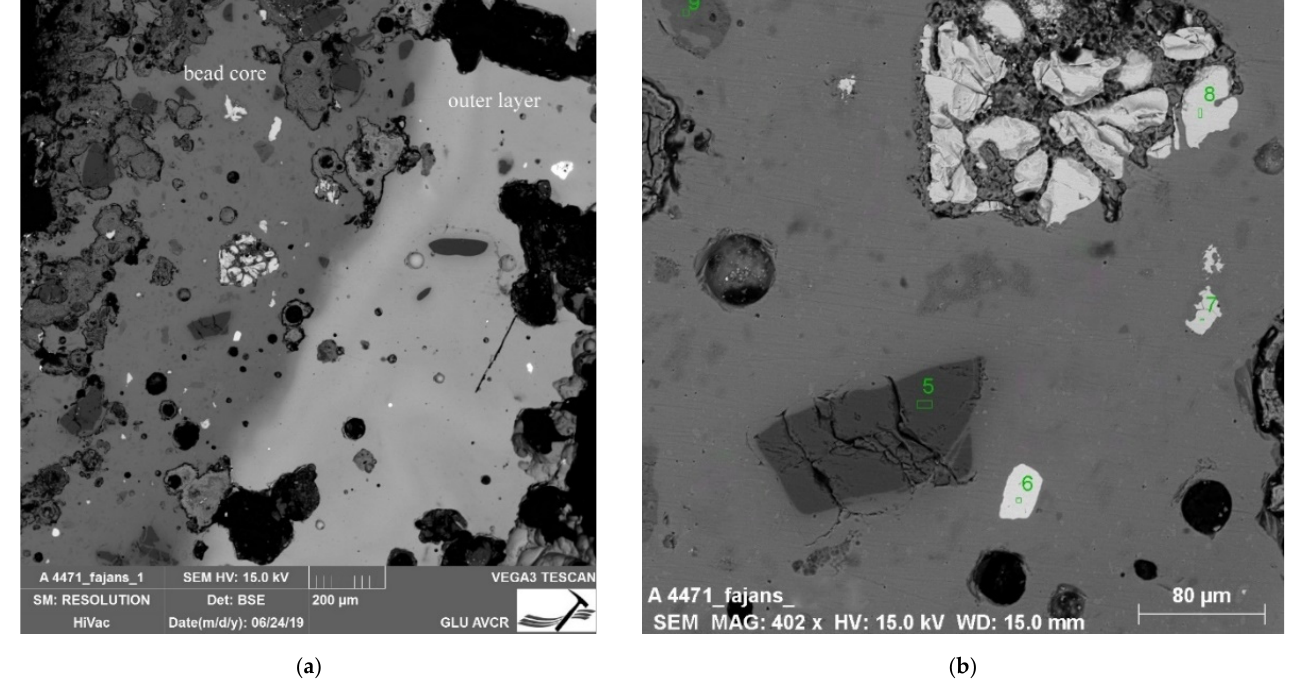
Figure 6. ( a ) Layer stratigraphy of Bead No. 10; the darker heterogeneous structure (to the left) represents the bead core with a high K 2 O content, while the shell of the bead with a more homogeneous structure can be seen on the right; ( b ) Detail of image ( a ) showing the bead core/internal layer. The glass mass contains SiO 2 (5) and Zr particles (6), iron-rich phases (7 and 8), and most likely feldspar grain (9).